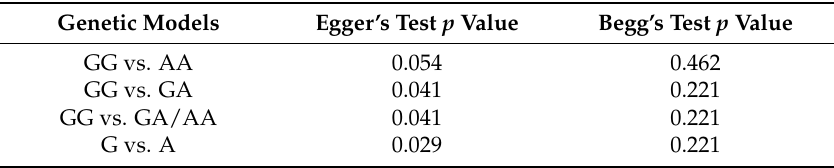
Figure 5. Begg’s funnel plot with pseudo 95% confidence limits for a heterozygous model (GG vs. GA) of rs2275913. Table 3. Egger’s and Begg’s test for the publication bias of